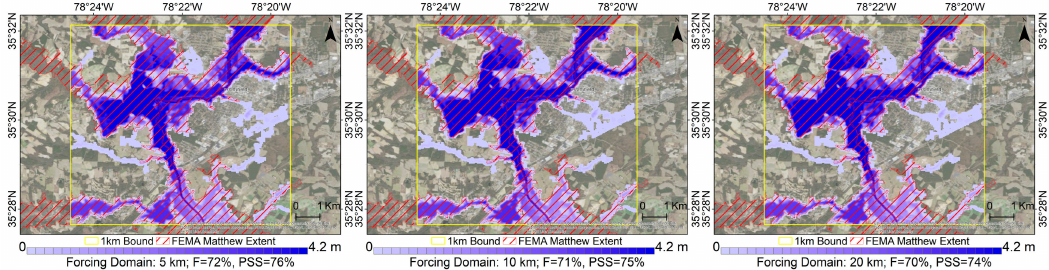
Figure 10. The changes in simulated inundated areas along with the increase in the size of the forcing domain where forcing was loaded, compared to the flood extents published by the U.S. Federal Emergency Management Agency